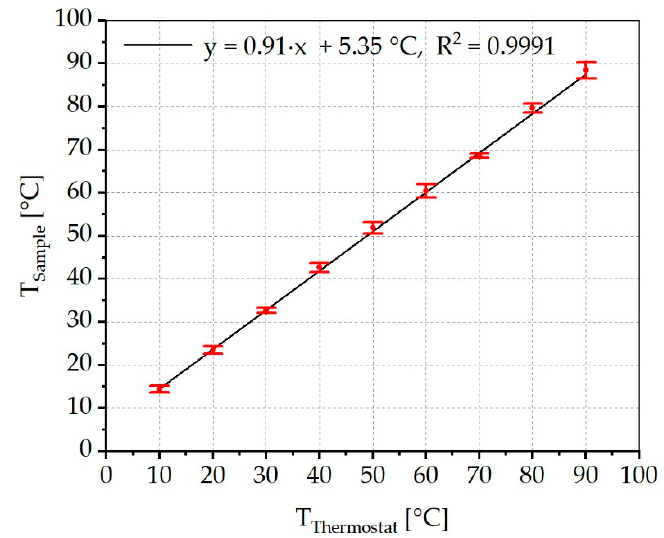
Figure 9. Sample surface temperature as function of the set thermostat temperature. The sample surface temperature increases by 0.91 °C per 1 °C of the set thermostat temperature.